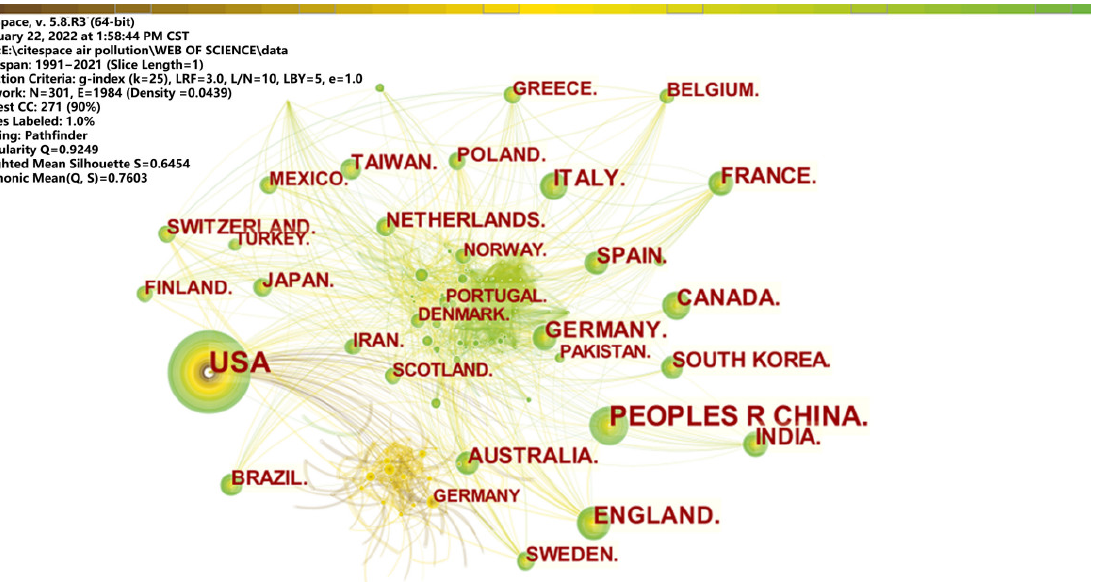
Figure 7. Co-occurrence knowledge mapping of the issuing countries.